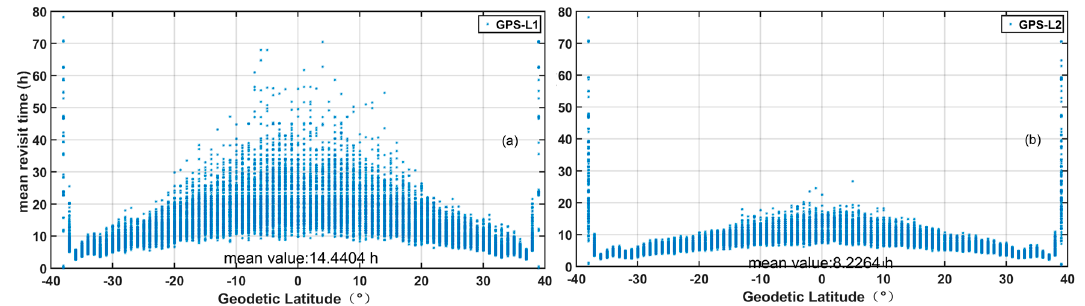
Figure 11. Mean revisit times in the bins for GPS-R at different latitudes during a single cycle at the GPS L1 ( a ) and L2 ( b ) frequencies.